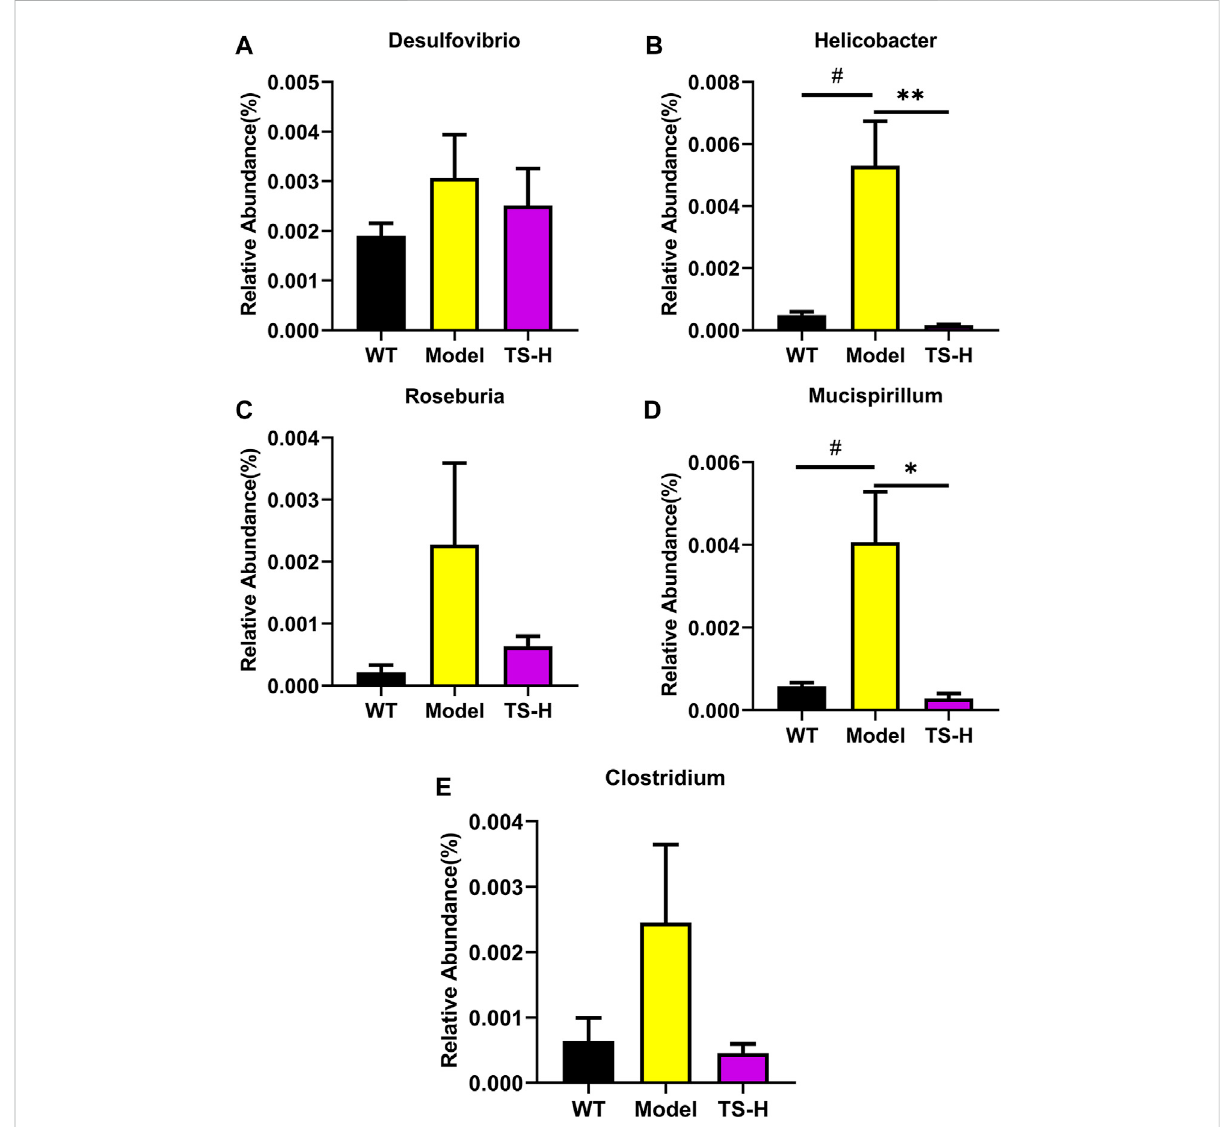
FIGURE 13 Relative abundance of fi ve representative microbial species at the genus levels in WT mice, APP/PS1 mice and TS treatment APP/PS1 mice. (A) Desulfovibrio . (B) Helicobacter ( # p = 0.0113, ** p = 0.0084). (C) Roseburia . (D) Mucispirillum ( # p = 0.0239, * p = 0.0169). (E) Clostridium . Data were expressed as mean ± SEM. # Compared with WT group; *Compared with model group ( n =